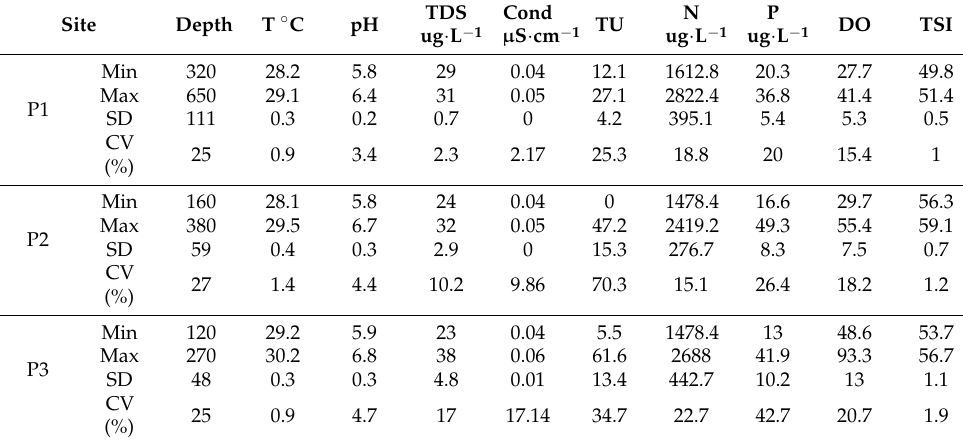
Table 3. Values minimum (Min), maximum (Max), standard deviation (SD) and coefficient of variation (CV%) for the three ponds under study.